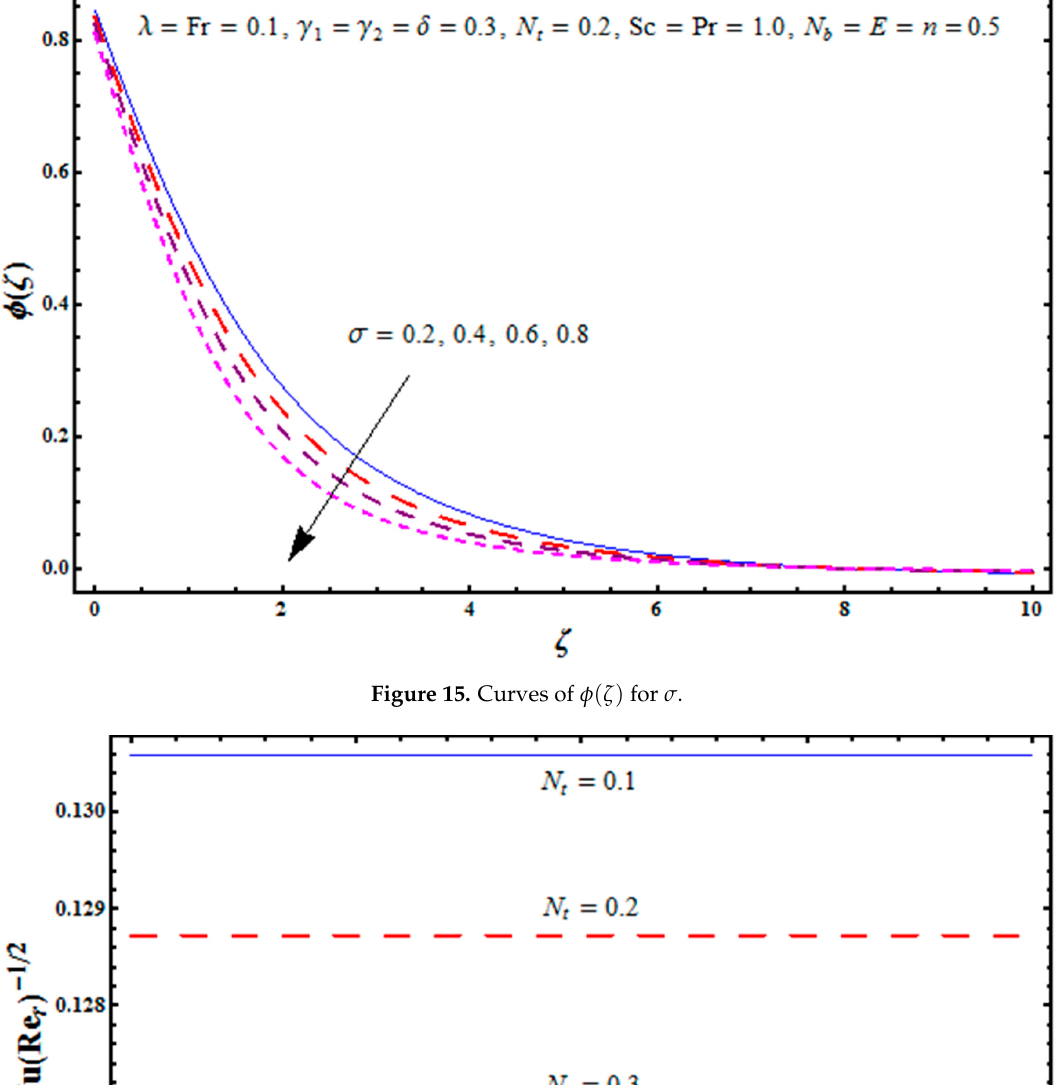
Figure 15. Curves of φ ( ζ ) for σ .